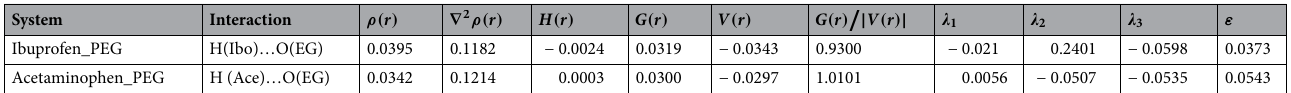
Table 5. The AIM topological parameters, including electron density ( ρ ), Laplacian of electron density ( ∇ 2 ρ (r)), the kinetic electron density G (r), potential electron density V (r), eigenvalues of Hessian matrix ( λ ) and bond ellipticity index ( ε ) of binary systems containing drugs and